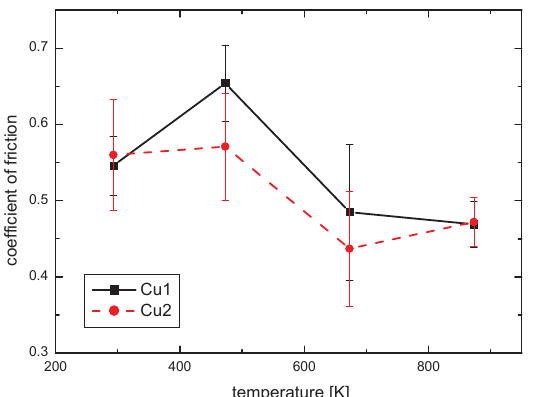
Figure 4. Coefficient of friction as function of